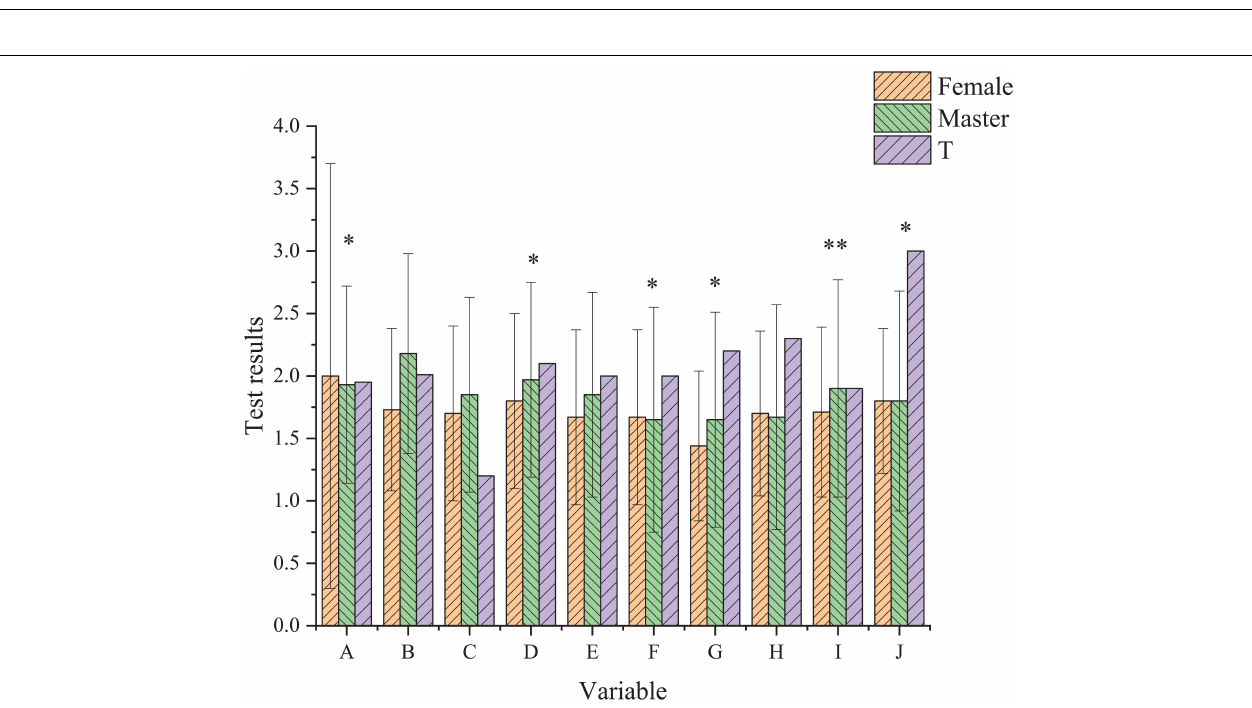
FIGURE 2 | Comparison of survey results of male and female college teachers ( ∗ p < 0.05, ∗∗ p < 0.01).